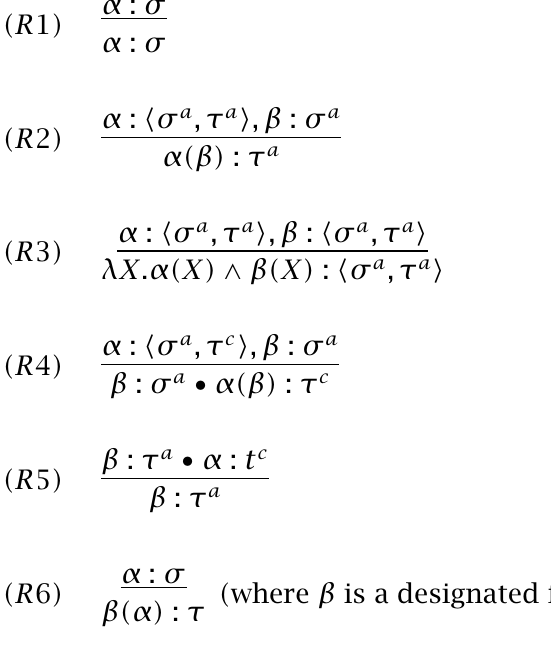
Figure 1 Rules of proof in L